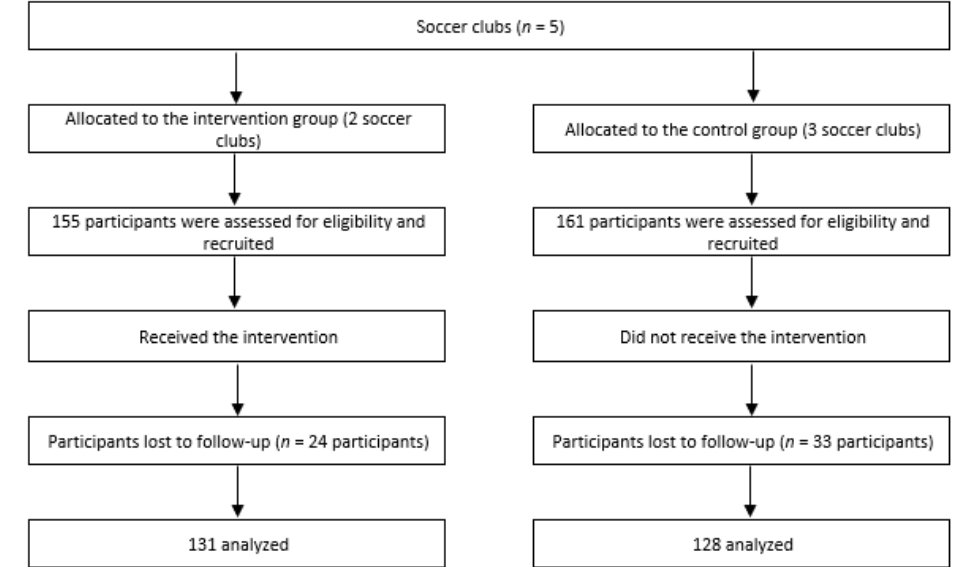
Figure 1. Flow diagram of participants. Table 2. Pre- and post-intervention median values for temperature, humidity, and physical activity time for the CG ( n = 128) and the IG ( n = 131), and the differences between the